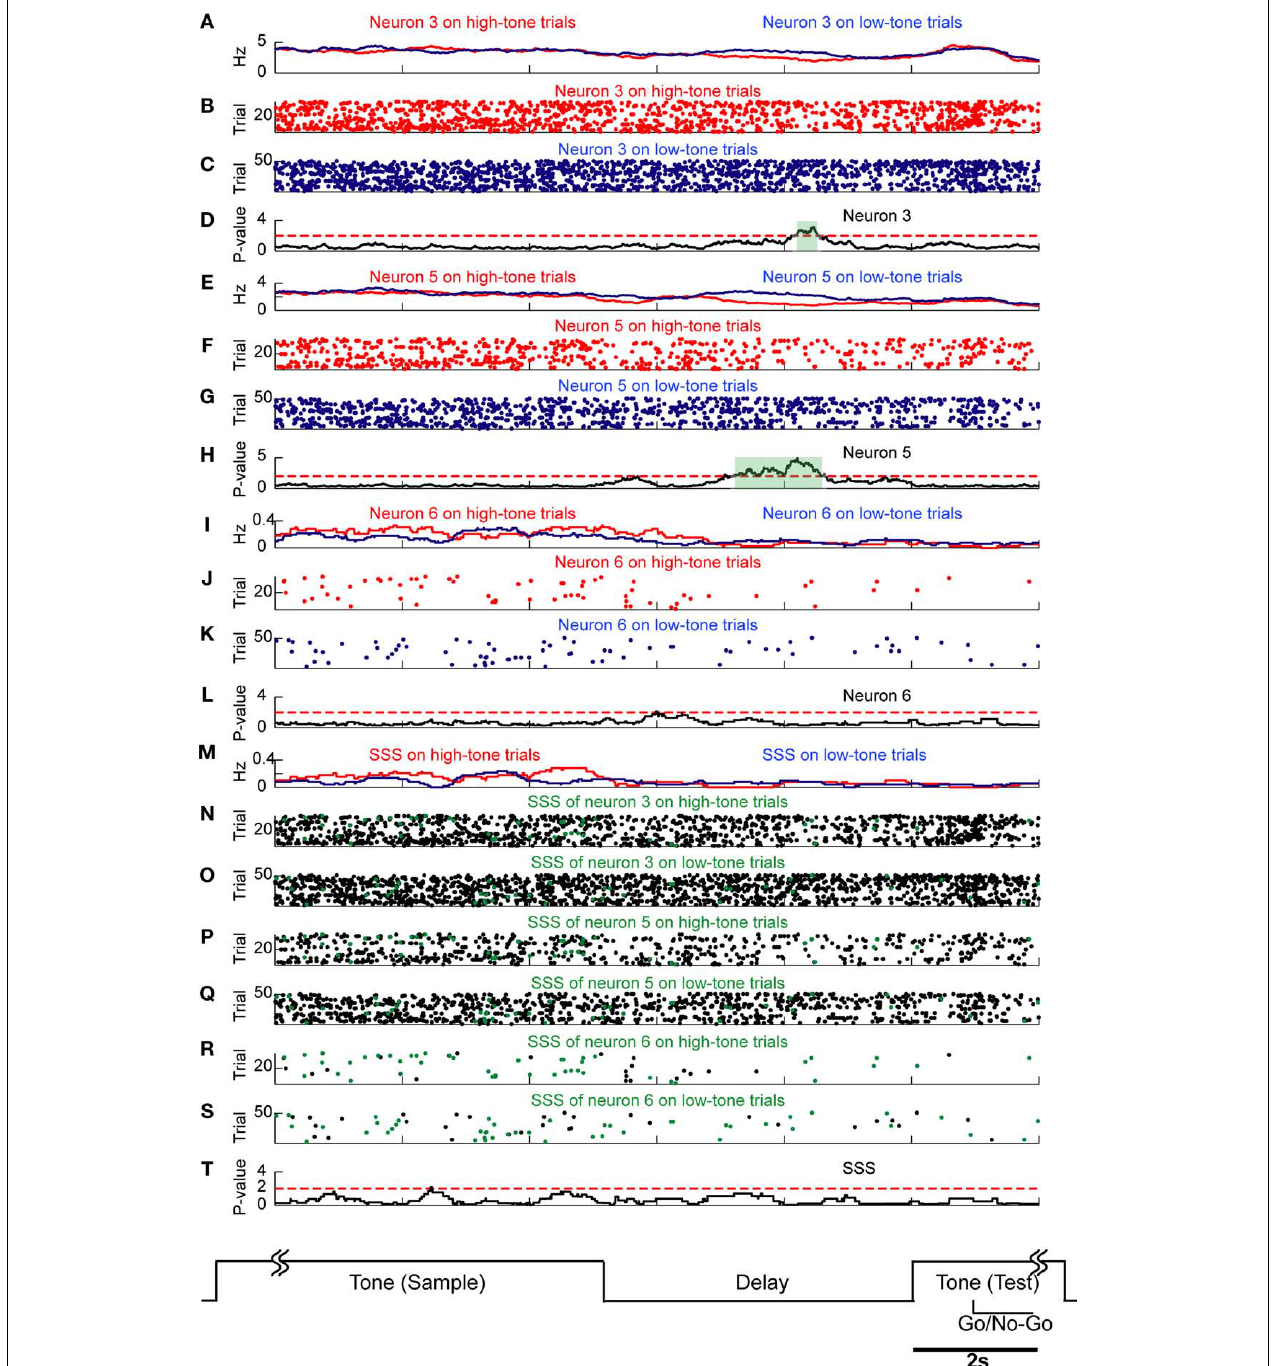
FIGURE 12 | Rate modulations related to stimulus inputs are not associated with SSSs among a triplet of neurons. Comparison of SSSs and rate modulations between high tone (red) and low tone (blue) trials was selected in this example. Results of U -tests of 5 s of tone presentation on the preceding trial, 5 s of delay, and 2 s of tone presentation in the next trial are shown. (A) Firing rates of neuron 3 in high tone (red) and low tone (blue) trials. (B,C) Raster plots of spikes of neuron 3 in high tone (red) and low tone (blue) trials. (D) P -values of neuron 3 for a difference between rates in high tone trials and in